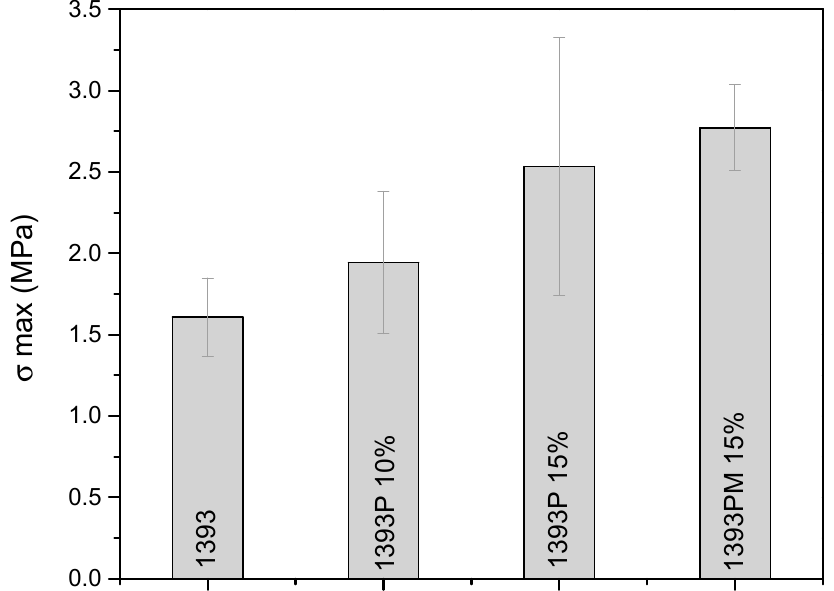
Figure 9. Mean values and standard deviation of compressive strength of 1393 uncoated and coated scaffolds.